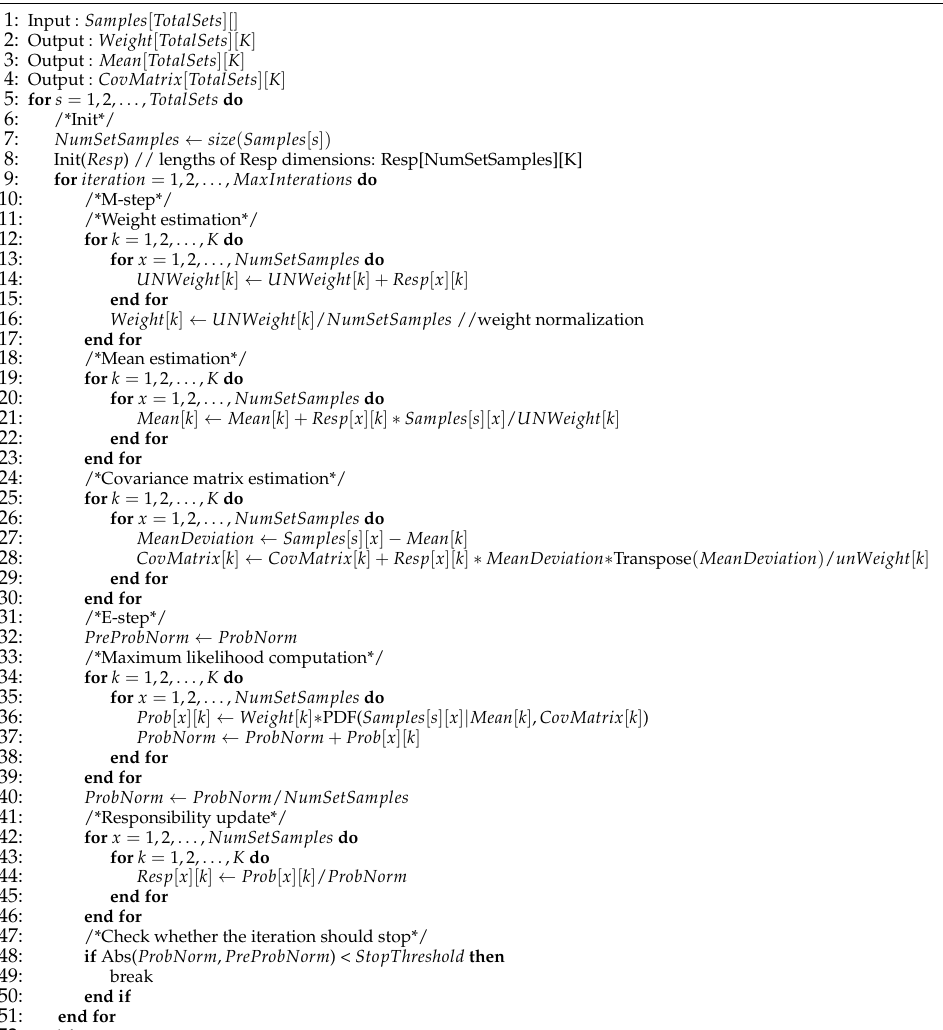
Algorithm 3 Serial Version of the Multi-set EM